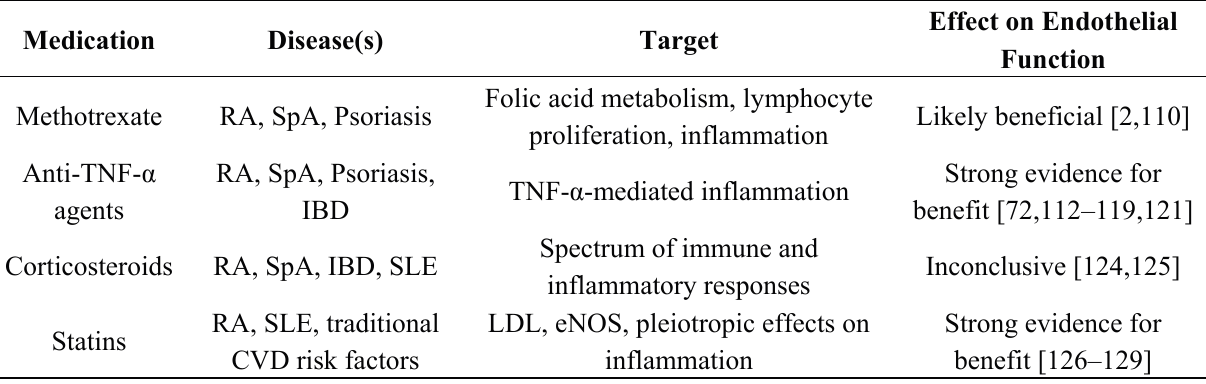
Table 2. Medication and Effect on Endothelial